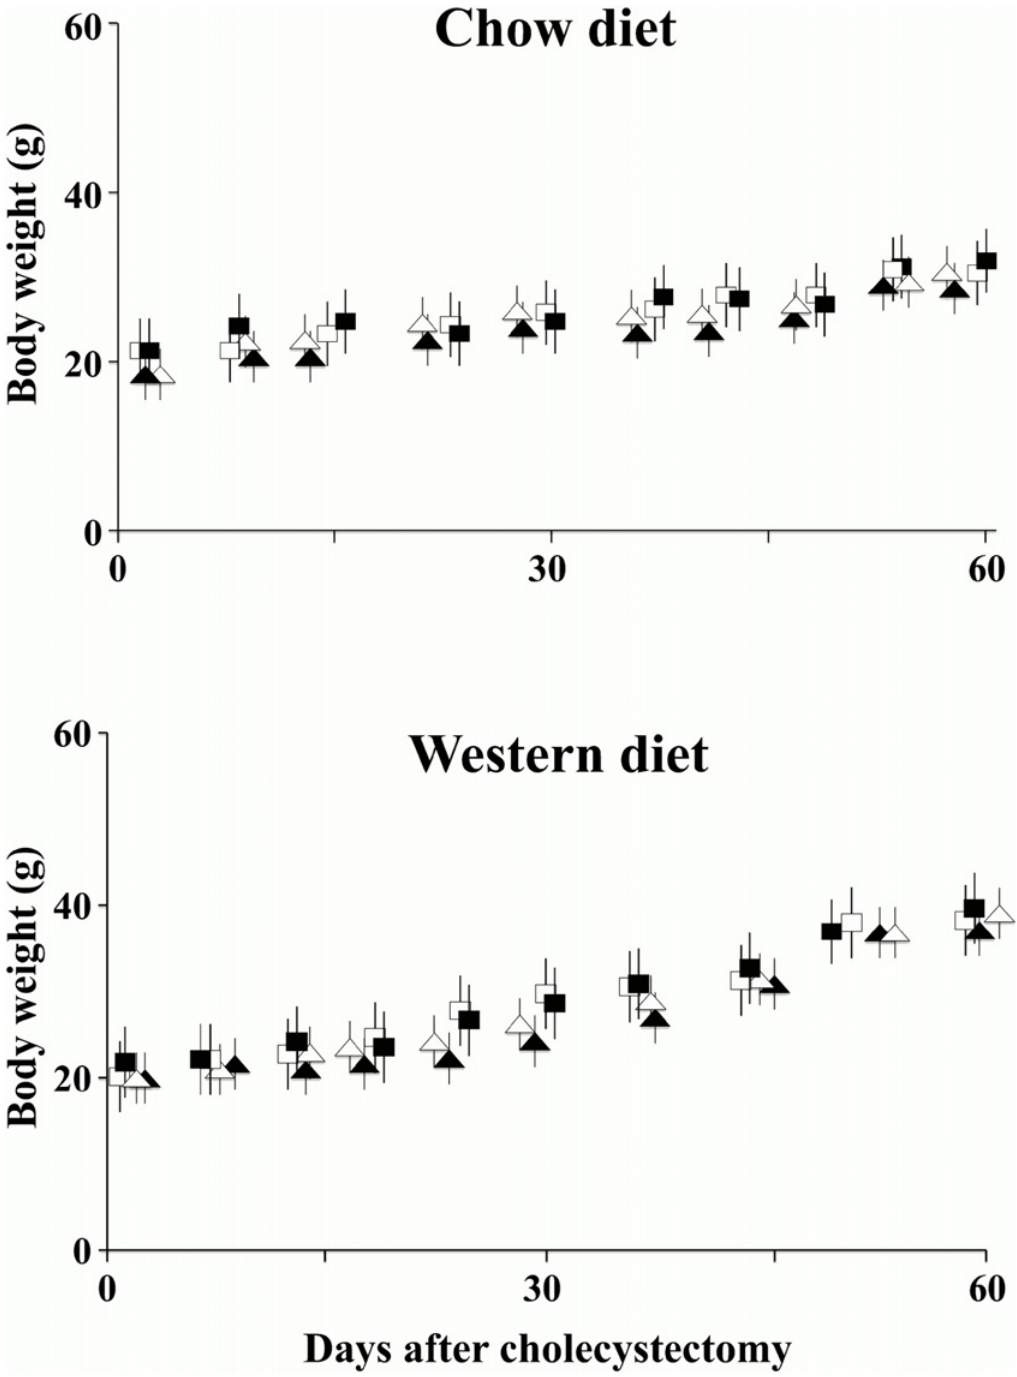
Fig 1. Body weights after XGB in wild type and Tgr5 -/- mice fed chow or WD. This figure presents 12 wild type and 6 Tgr5 -/- sham-operated mice or subjected to XGB. Initial weight of wild type and 6 Tgr5 -/- mice were 19 to 23 g. Values represent the mean ± S.E.M. Final weights at the specific experiments 37 – 40 days after surgery were significantly increased by 53% to 65% in all groups of mice fed the WD compared to groups of mice fed the normal chow (p < 0.02). These differences were maintained throughout the observational period of 60 days. XGB had no effects on body weight changes. Values represent the mean ± S.E.M. Squares represent wild — type and triangles represent Tgr5 -/- mice. White figures and black figures represent sham — operated and mice subjected to XGB, respectively.